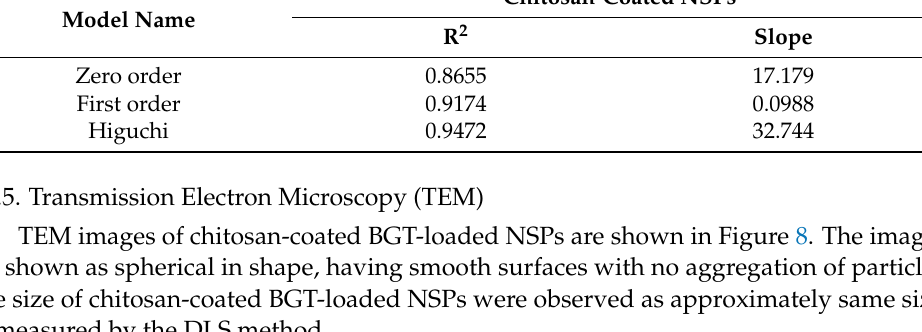
Table 3. Drug release kinetic models for optimized chitosan-coated NSPs.